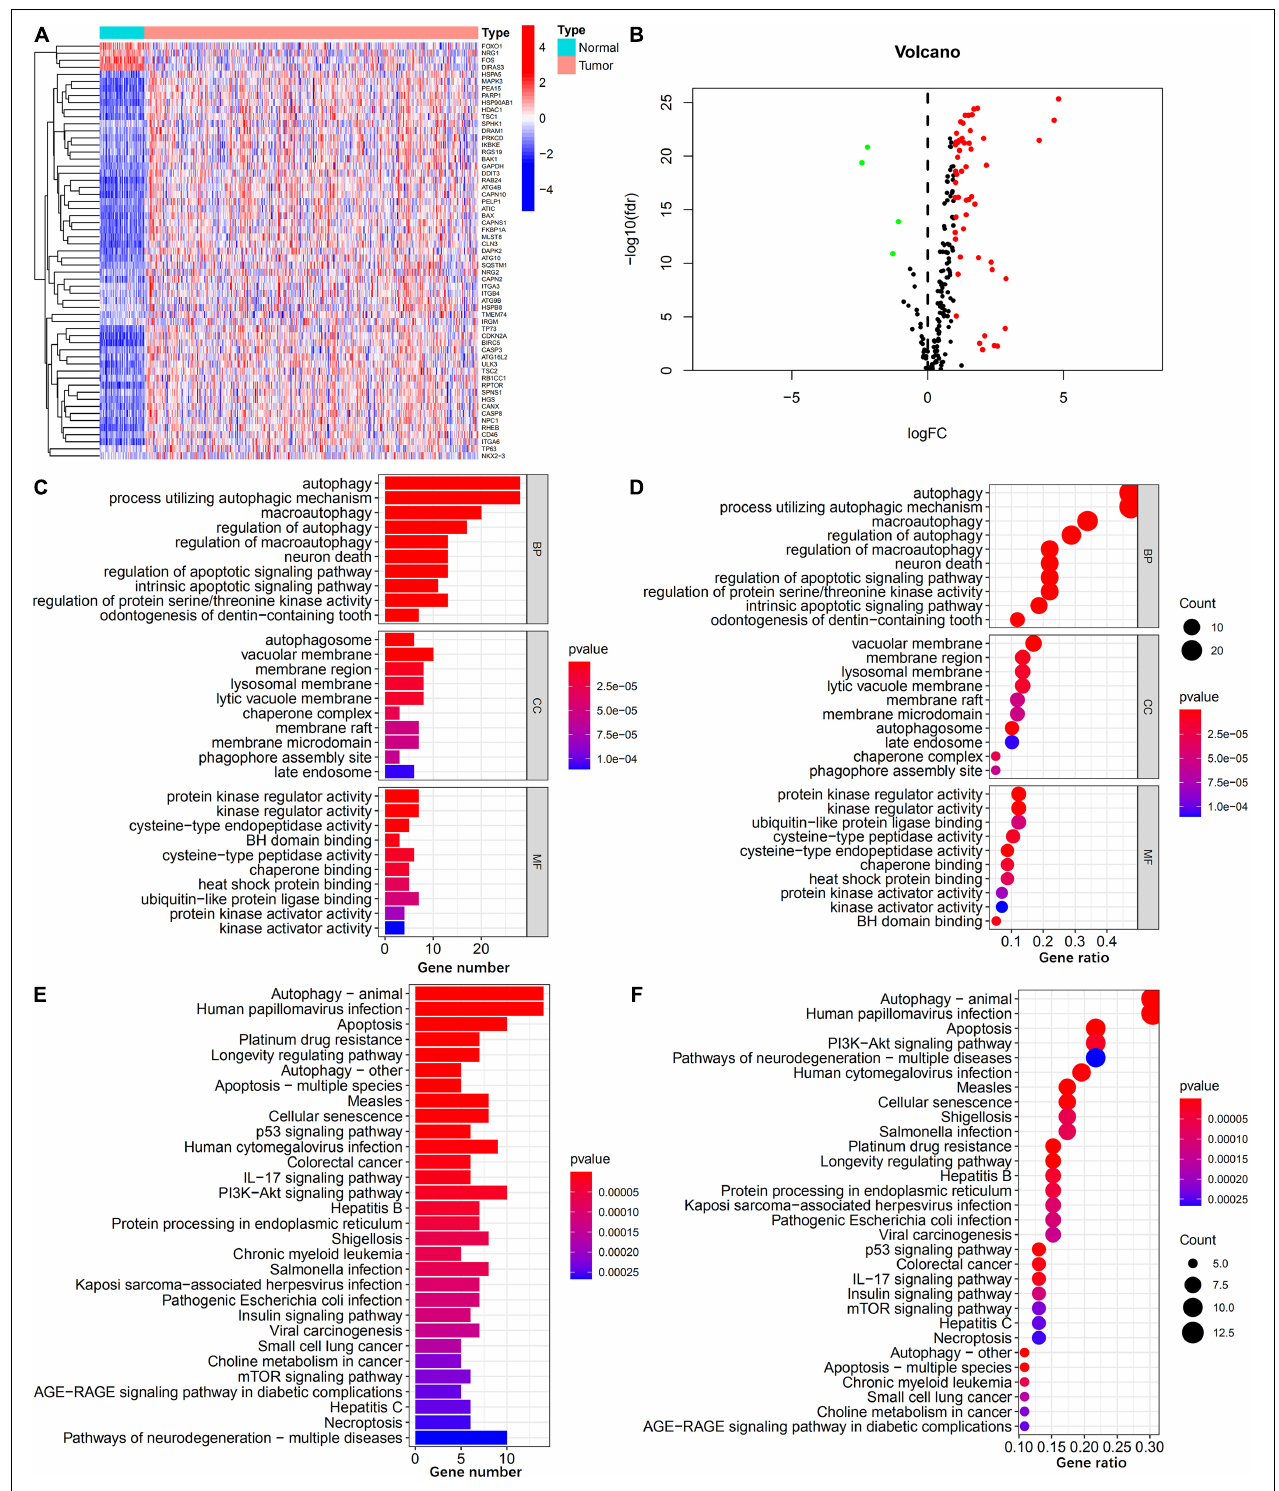
FIGURE 2 | Identification of differentially expressed ARGs. (A,B) Heatmap and volcano plot illustrates the expression of 59 differentially expressed ARGs between HCC tumor and non-tumor specimens. (C,D) Barplot and bubble plot of GO analysis shows the top 10 biological functions of the differentially expressed ARGs in the biological processes, cellular components, and molecular functions. (E,F) Barplot and bubble plot of KEGG analysis shows the top 30 signaling pathways of the differentially expressed ARGs participated in.